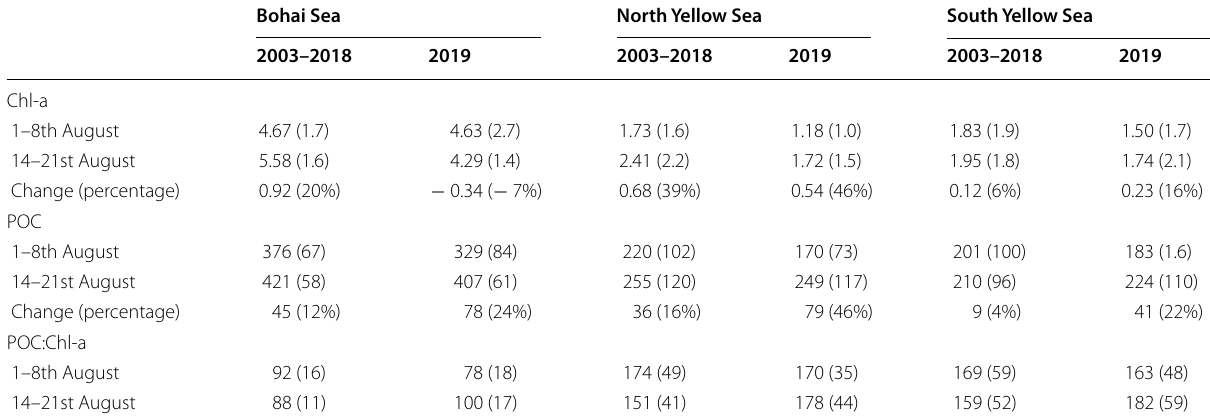
Table 1 Means (standard deviations) of Chl‑a (mg m − 3 ) and POC (mg m − 3 ) and their changes (percentages) from 1–8th to 14–21st in August of 2019 and non‑typhoon years over 2003–2018 Bohai Sea North Yellow Sea South Yellow